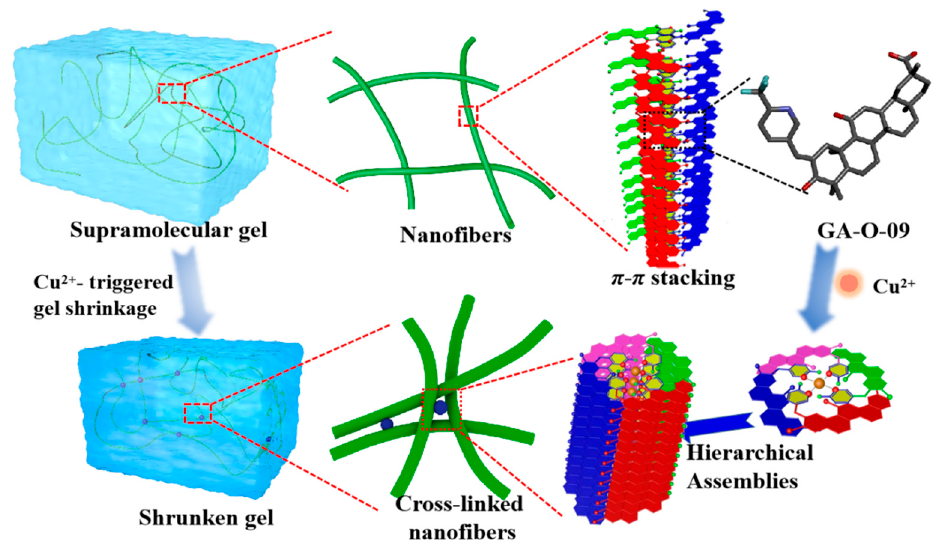
Figure 4. The schematic representation of the Cu 2+ -triggered macroscopic gel shrinkage with changes at the nanoscale.